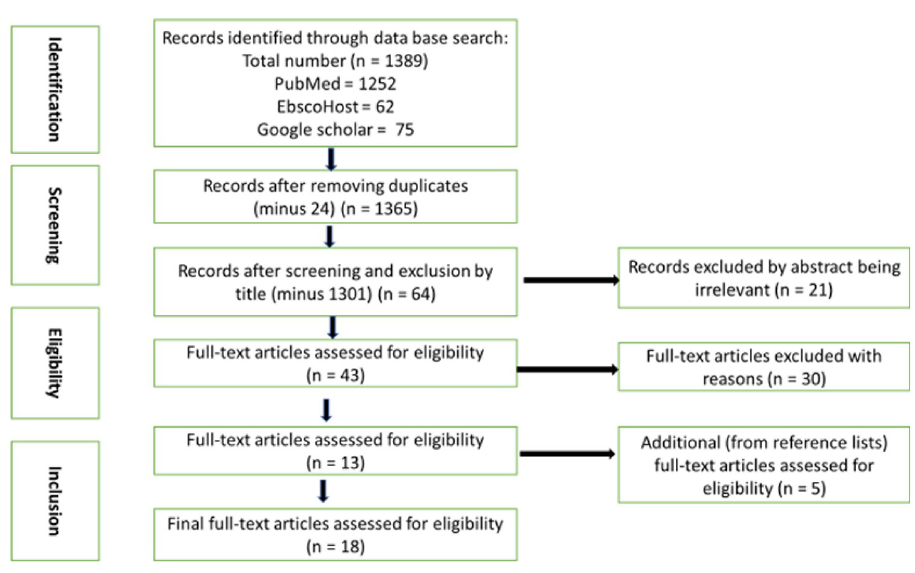
Fig 1. PRISMA flow diagram showing steps followed to select